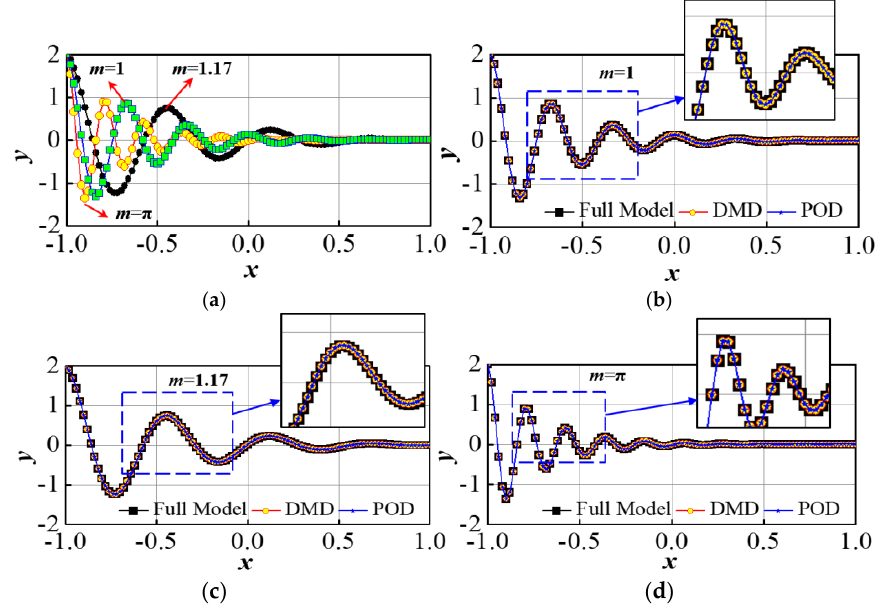
Figure 2. ( a ) Distribution of y for m = 1, 1.17 and 𝜋 with full model analysis; Comparison of the DMD based reduced model with full model and DEIM model for ( b ) m = 1, ( c ) m = 1.17 and ( d ) m = 𝜋 .